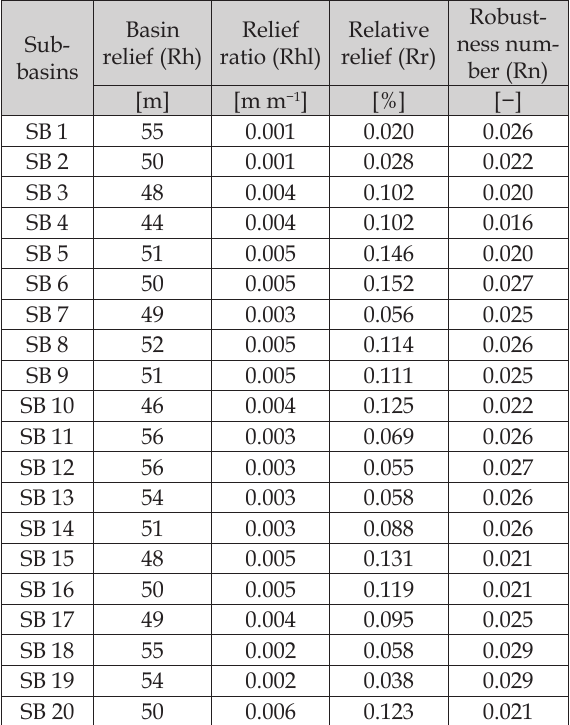
Table 5. Aspect parameters related to the relief of the Soungrougrou